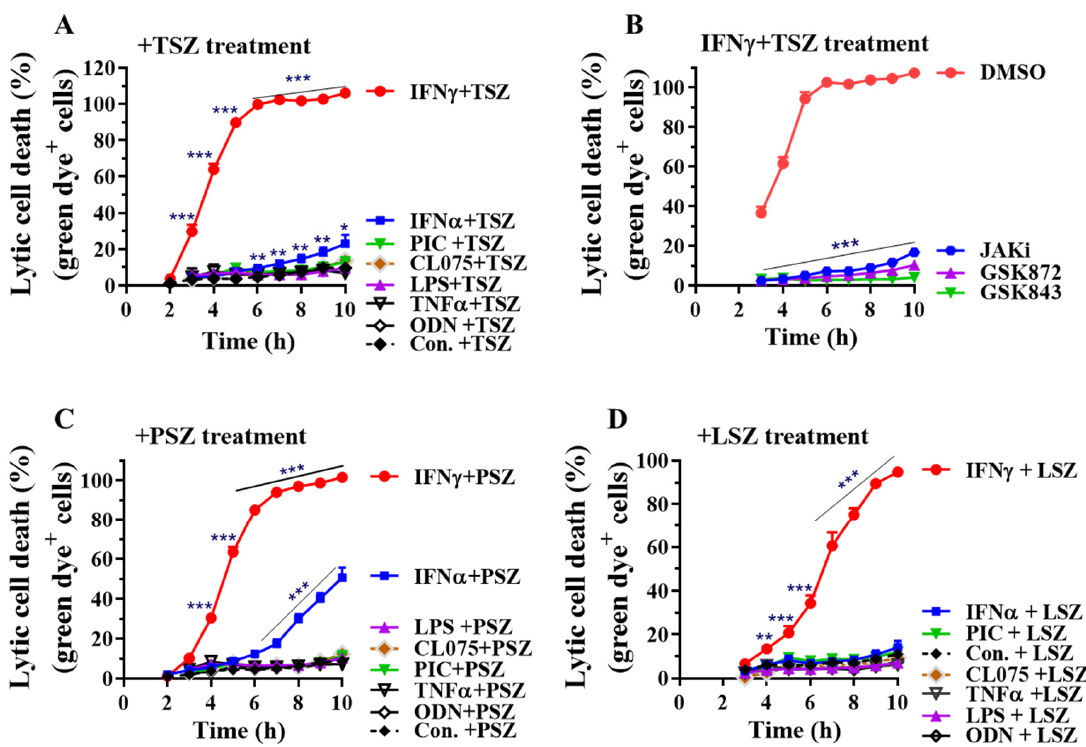
Figure 2. IFN γ preferentially promotes AEC necroptosis by real-time lytic cell death analysis. Mouse primary AECs were incubated with control PBS (Con.), IFN α 2 (50 ng/mL), IFN γ (50 ng/mL), TNF α (25 ng/mL), LPS (100 ng/mL), poly(I:C) (PIC, 0.5 µ g/mL), CL075 (1 µ g/mL) or ODN1585 (1 µ M) for 24 h, then treated in a 0–10 h period with DMSO, or TNF α (15 ng/mL) plus 100 nM Smac mimetic AZD5582 and 25 µ M z-VAD-FMK ( A , +TSZ), poly(I:C) (0.2 µ g/mL) plus 100 nM Smac mimetic and 40 µ M z-VAD-FMK ( C , +PSZ) or LPS (200 ng/mL) plus 100 nM Smac mimetic AZD5582 and 25 µ M z-VAD-FMK ( D , +LSZ) in the presence of an asymmetric cyanine dye. ( B ) Mouse AECs were incubated without or with IFN γ (50 ng/mL) in the presence of DMSO or JAK kinase inhibitor-1 (JAKi, 1 µ M) for 24 h, washed and then subjected to TSZ-induced real-time necroptosis assay as described above in the presence of DMSO, GSK872 (5 µ M), GSK843 (2 µ M) or JAKi (1 µ M). The percentage of lytic cell death (green dye + cells) was calculated by comparison to the maximal fluorescence induced by a lysis buffer in each group and presented as mean ± SE. In panel ( A ): Con.+TSZ, n = 16; IFN γ +TSZ, n = 15; IFN α +TSZ, n = 11; other treatments, n = 4–6. In panel ( B ): DMSO, n = 10; others, n = 5–7. In panel ( C ): Con.+PSZ, n = 15; IFN γ +PSZ, n = 14; IFN α +PSZ, n = 10; other treatments, n = 4–5. In panel ( D ): Con.+LSZ, n = 8; IFN γ or IFN α +LSZ, n = 6; other treatments, n = 4–5. Two-way ANOVA and unpaired Student’s t test were performed in ( A – D ). * p < 0.05; ** p < 0.01; *** p < 0.001 versus control (Con.) or DMSO in each group. The orders of each agonist-induced percentage of lytic cell death were listed on the right in panels ( A , C , D